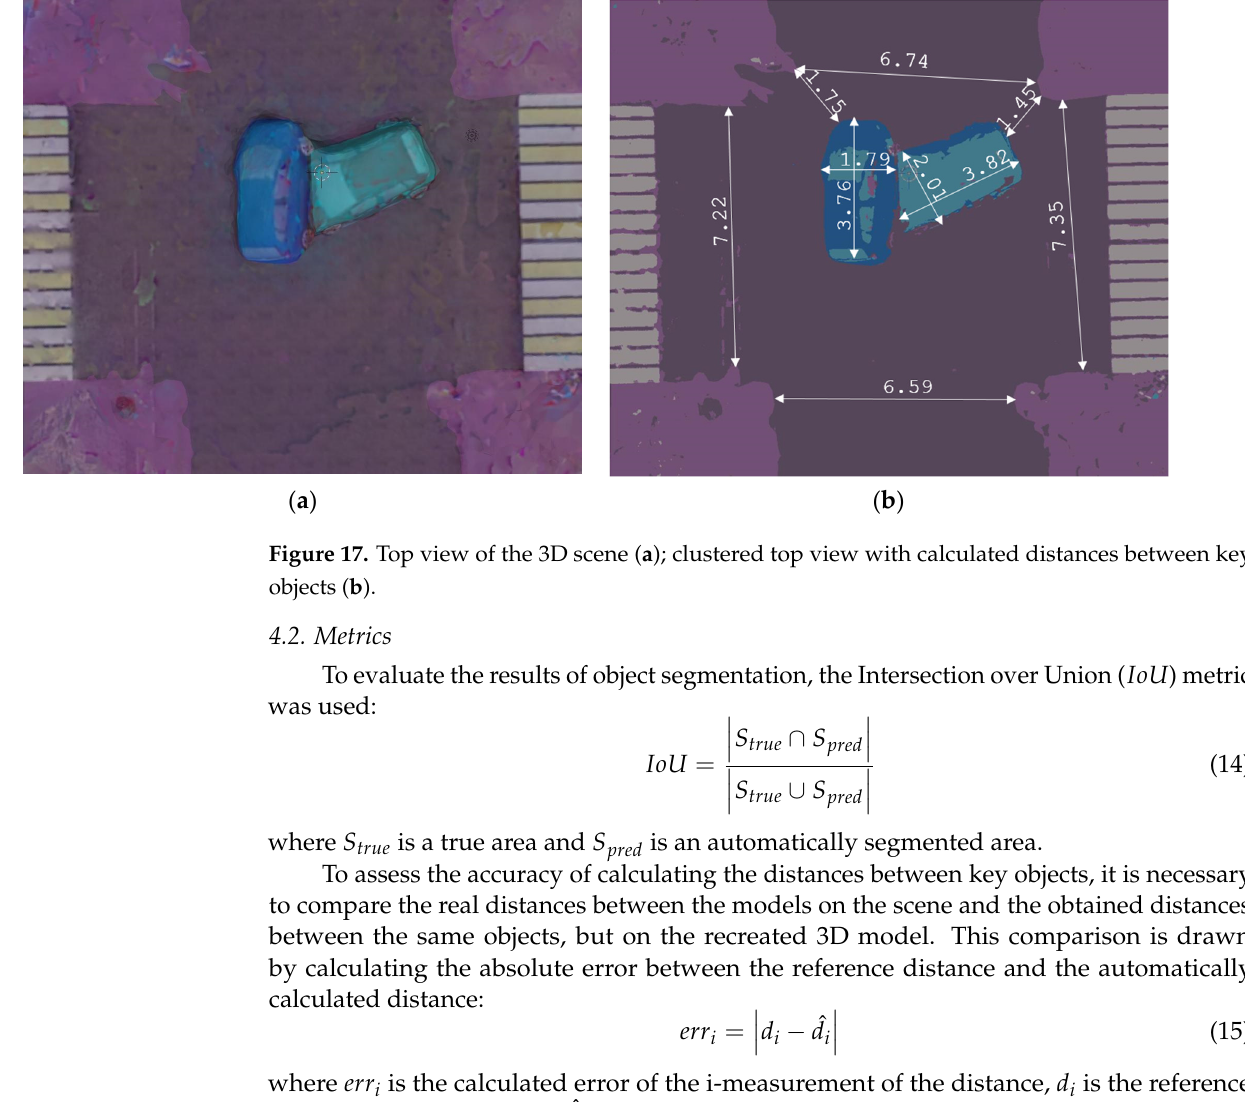
Figure 16. 3D scene. With photogrammetry based on segmented images, the resulting textures contain information about segmented objects in the form of characteristic colors.